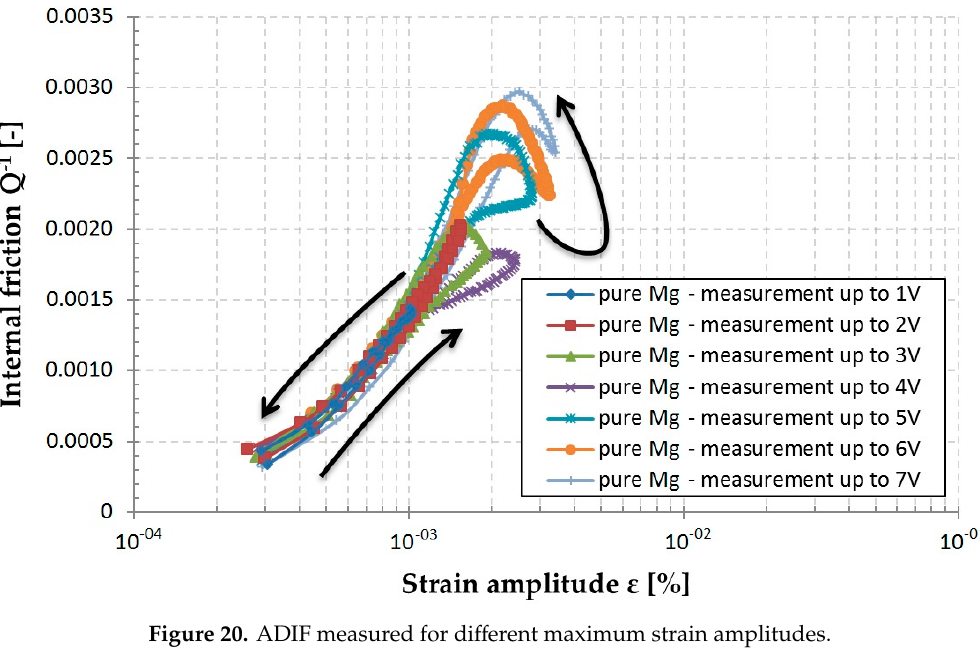
Figure 20. ADIF measured for different maximum strain amplitudes.